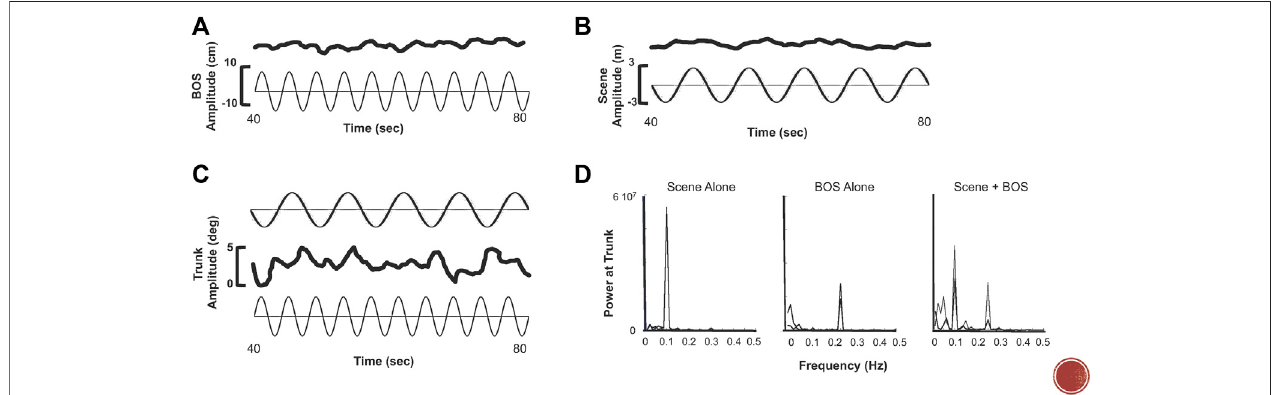
FIGURE 1 | (A) Trunk excursion (top trace) to sinusoidal a-p translation (bottom trace) of the base of support (BOS) at 0.25 Hz. (B) Trunk excursion (top trace) to sinusoidal a-p optic fl ow (scene) at 0.1 Hz. (C) Trunk excursion (middle trace) when 0.25 Hz motion of the BOS (bottom trace) and 0.1 Hz of the scene (top trace) occur simultaneously. (D) FFTanalysisdemonstratingpoweratthetrunkre fl ectsfrequencyofthestimulus,i.e.,thescene (left) ,theBOS (middle) ,andsimultaneousBOSand scene motion (right) .